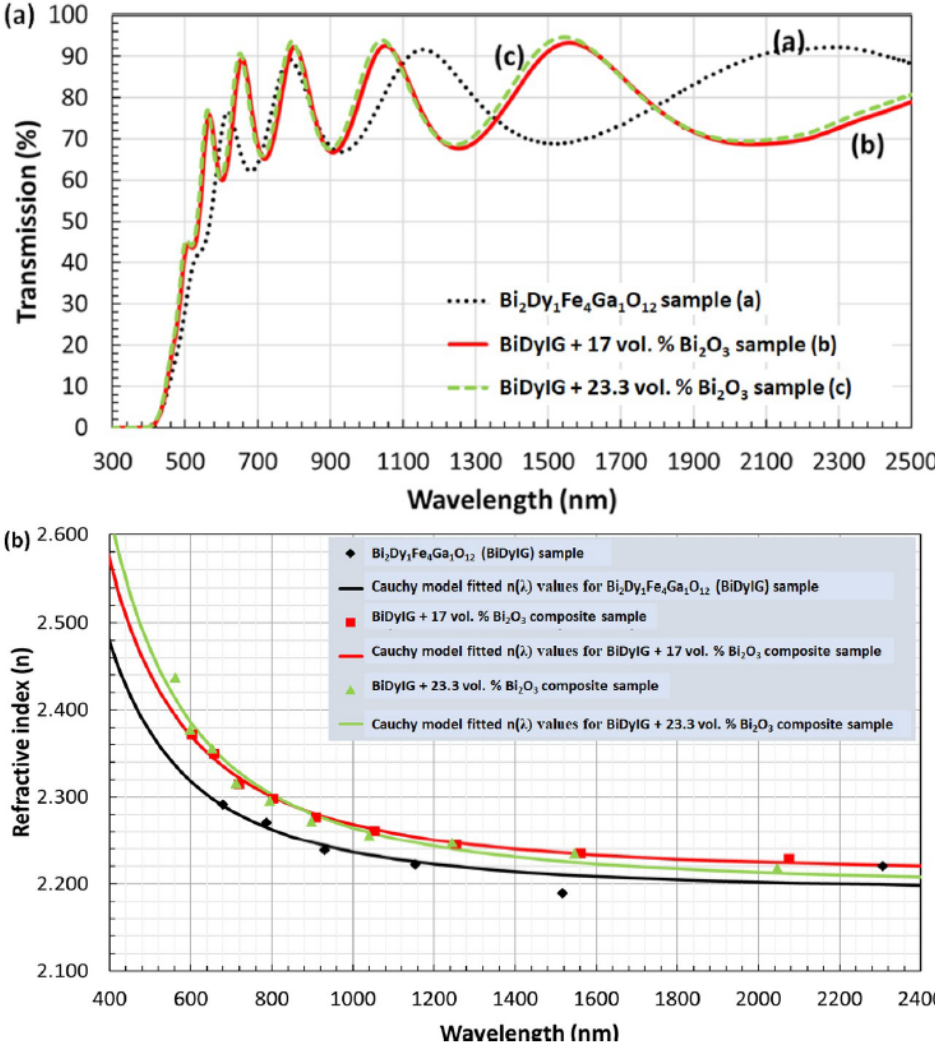
Figure 2. ( a ) Measured transmission spectra of as-deposited Bi 2 Dy 1 Fe 4 Ga 1 O 12 (BiDyIG) and BiDyIG: Bi 2 O 3 (17 and 23.3 vol. %) composite thin films, ( b ) derived refractive index dispersion spectra for Bi 2 Dy 1 Fe 4 Ga 1 O 12 (BiDyIG) and BiDyIG:Bi 2 O 3 (17 and 23.3 vol. %) composite thin films where the solid curves were determined according to Cauchy dispersion